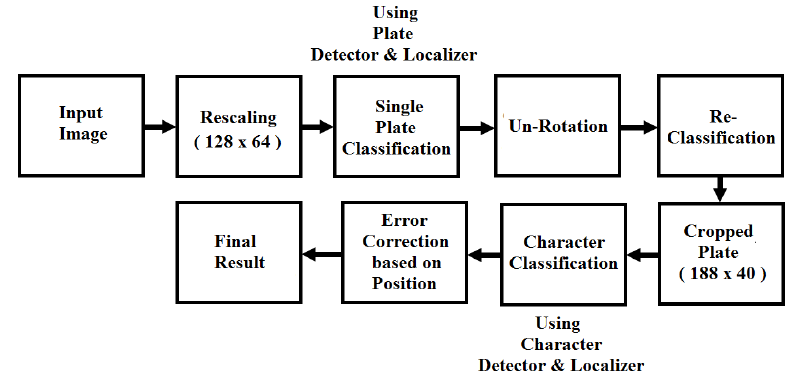
Figure 4. Simplified flow of neural network-based automatic license plate recognition system.